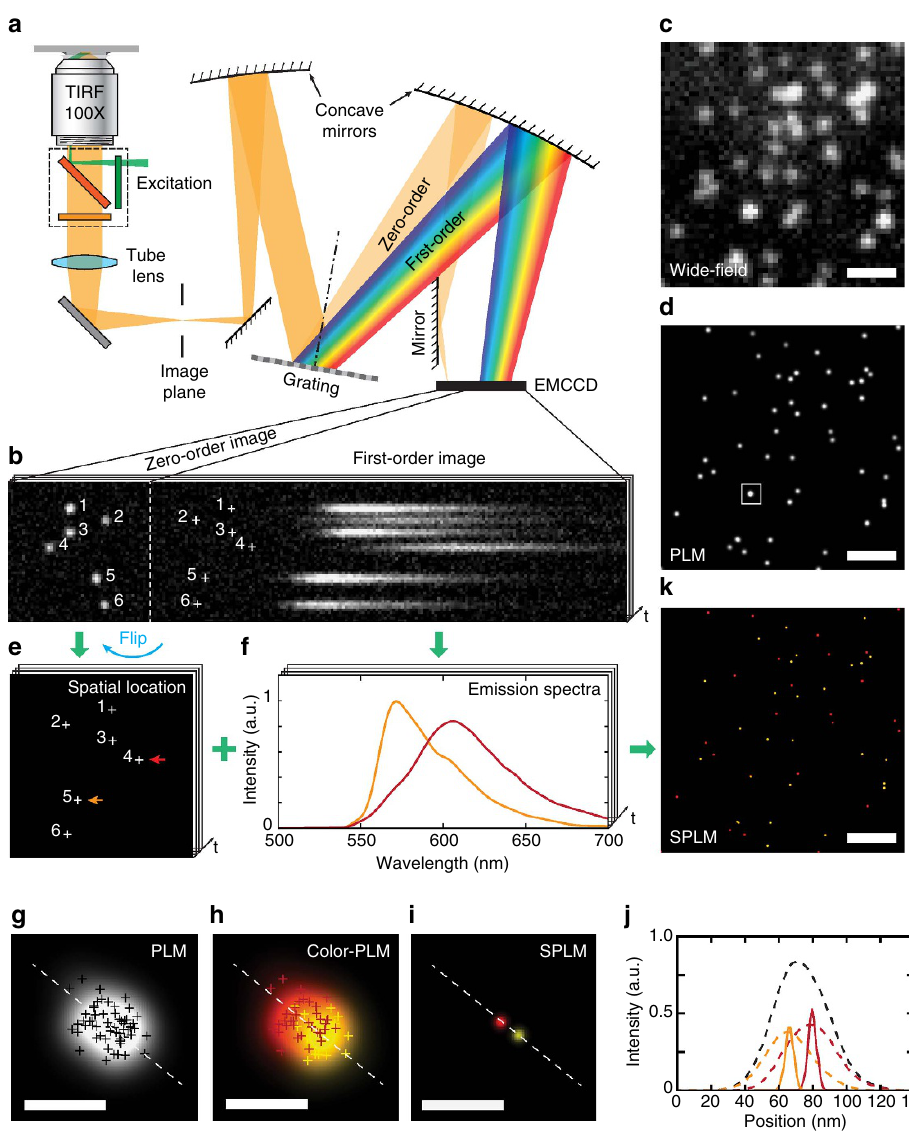
Figure 1 | The working principle of SPLM. ( a ) Schematic of the SPLM system. Upon laser excitation, the fluorescent image was collected by a high- numerical aperture objective lens and subsequently coupled into a Czerny–Turner monochromator by a match tube lens. ( b ) Both the zero-order and the first-order diffractions from the grating were recorded simultaneously using the same EMCCD camera. ( c ) Wide-field optical image of the sample consisting of actin monomers labelled by Alexa Fluor 532 and Alexa Fluor 568 with diffraction-limited resolution. ( d ) The conventional PLM method offers sub-diffraction-limited imaging resolution, but is unable to capture the spectroscopic signature of the individual emitter. Scale bars: 1 m m ( c , d ). ( e ) The localization algorithm was used to determine the spatial locations of each blinking, illustrated by numbered crosses. These locations can be further used as the inherent reference points for spectral calibration of the emission spectra in the first-order image, shown as denoted crosses in b . ( f ) Representative spectra from two individual blinking events (highlighted by the coloured arrows in e ). ( g ) Magnified view of the square region in the PLM image ( d ). ( h ) Corresponding colour-coded image by separating the spectra of individual stochastic localizations according to the emission characterization of the two dyes. The spectral regression of nearby localizations indicates the cluster consisted of two single-dye molecules. ( i ) By averaging the nearby localizations, the SPLM image with spectral regression shows the localization precision of two molecules. Scale bars, 50nm ( g – i ). ( j ) Line profiles were used to compare the localization precision of PLM (black dashed line), colour-PLM (coloured dashed lines) and SPLM (coloured solid lines). ( k ) The super-resolution spectroscopic image was obtained by combining the spatial and spectroscopic information from all localizations. Scale bar, 1 m processing. The centroid position serves two roles: (1) to from the sample, must be carefully removed. In this work, the determine the location of each activated fluorescent molecule background signals were removed by subtracting the average of (shown as numbered crosses in Fig. 1e) and (2) to establish a the adjacent image frames without the presence of stochastic reference point to the corresponding emission spectrum from the emission (Supplementary Fig. 2). The dispersion of the imaging measured first-order image (shown as numbered crosses in system was calibrated prior to image acquisition (Supplementary Fig. 1b). Fig. 3). The recorded spectrum from first-order image was further To obtain optimal spatial and spectral resolutions, background normalized by the wavelength-dependent characteristic of optical signals, such as auto-fluorescence, Raman, or Rayleigh scattering components and EMCCD (Supplementary Fig. 4). Taking into